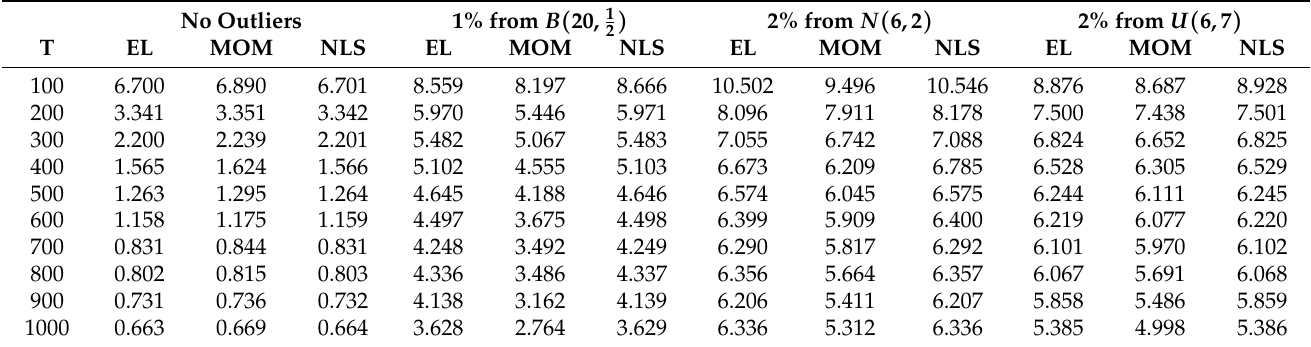
Table 3. MSE for (cid:98) θ NLS , (cid:98) θ MOM and (cid:98) θ EL in Example